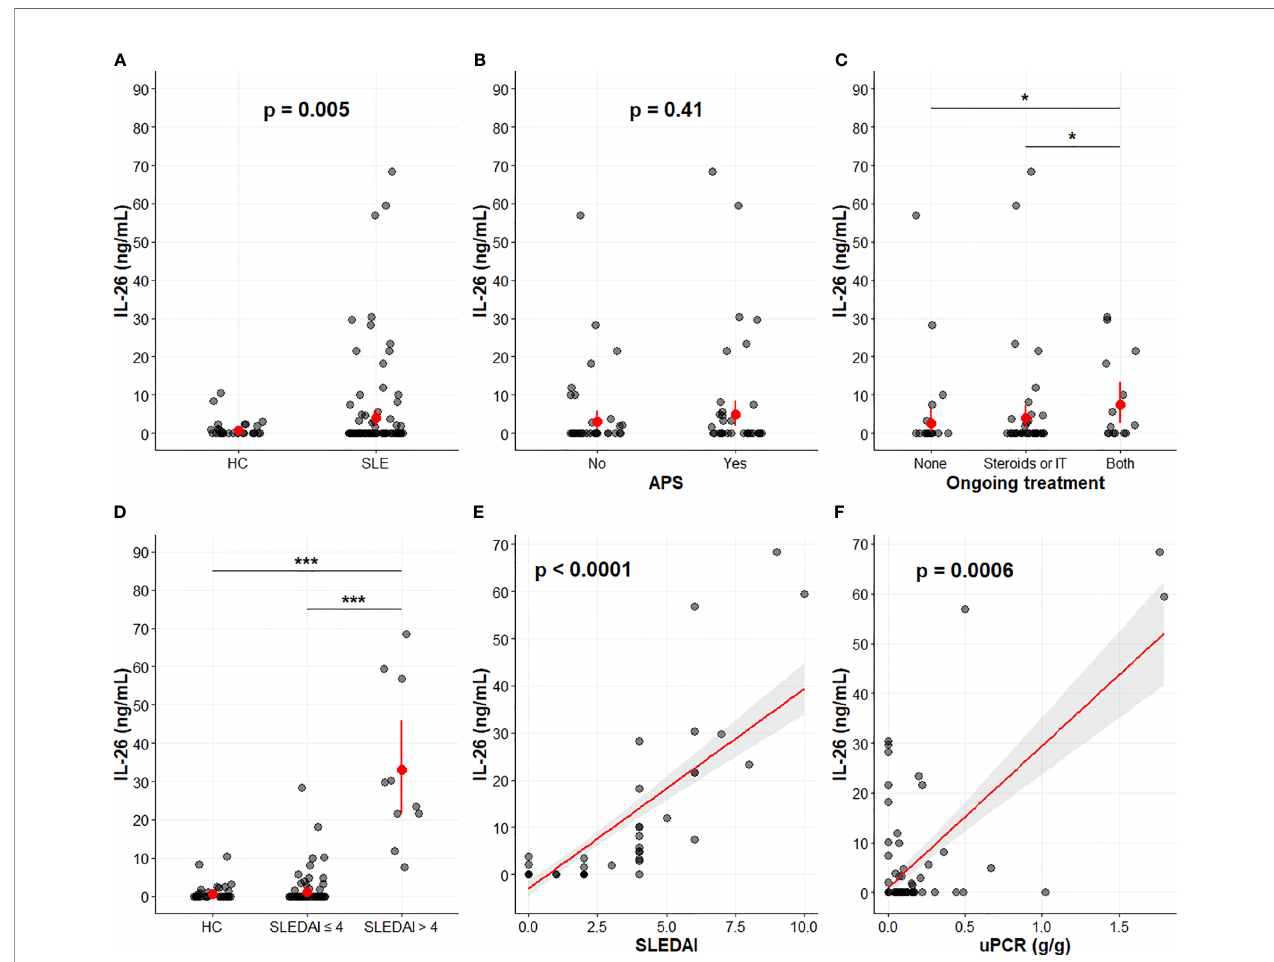
FIGURE 1 | IL-26 levels in SLE. IL-26 levels according to SLE status (A) , APS status (B) , and ongoing treatment (C) . Correlation between IL-26 levels and SLEDAI (D, E) or the urine protein to creatinine ratio (F) . (A – D) In red, mean ± 95% con fi dence interval. (E, F) Graphs depict the linear regressions (red) with the 95% con fi dence intervals (grey). Spearman correlation coef fi cients ( r ) were 0.70 (p < 0.0001) between IL-26 and SLEDAI (E) and 0.32 (p = 0.0006) between IL-26 and uPCR (F) . *p < 0.05. ***p < 0.001. APS, antiphospholipid syndrome; HC, healthy controls; IT, immunosuppressive therapy; SLE, systemic lupus erythematosus; SLEDAI, systemic lupus erythematosus disease activity index; uPCR, urine protein to creatinine